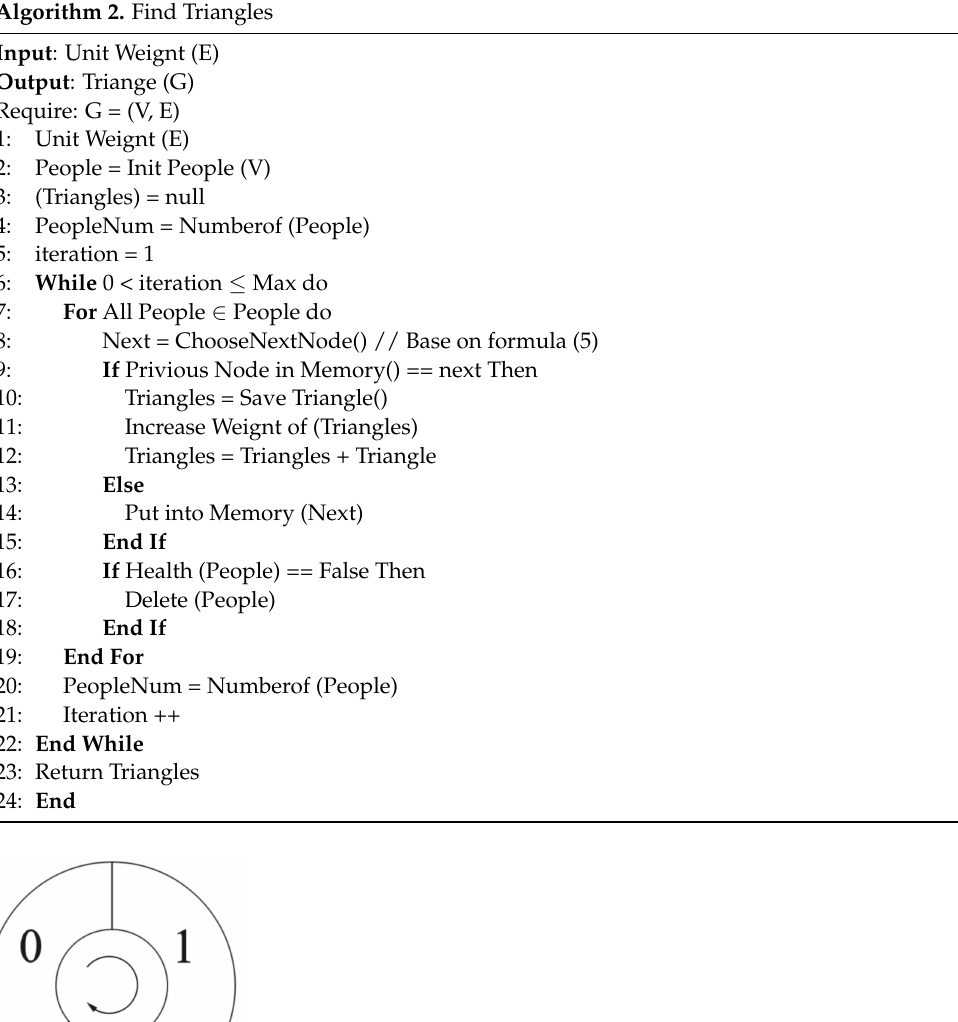
Algorithm 2. Find Triangles